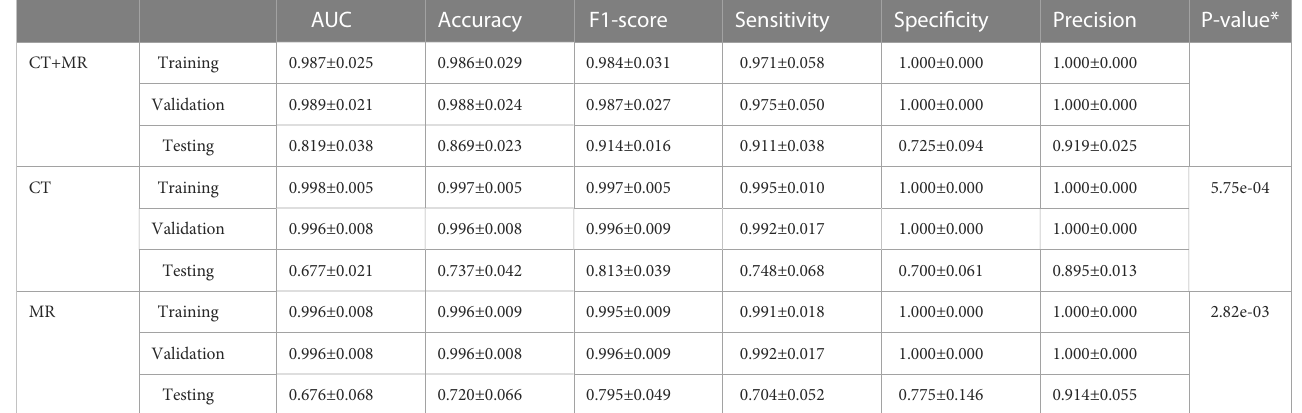
TABLE 3 Comparison results of the proposed method on mono-modality data and multi-modality